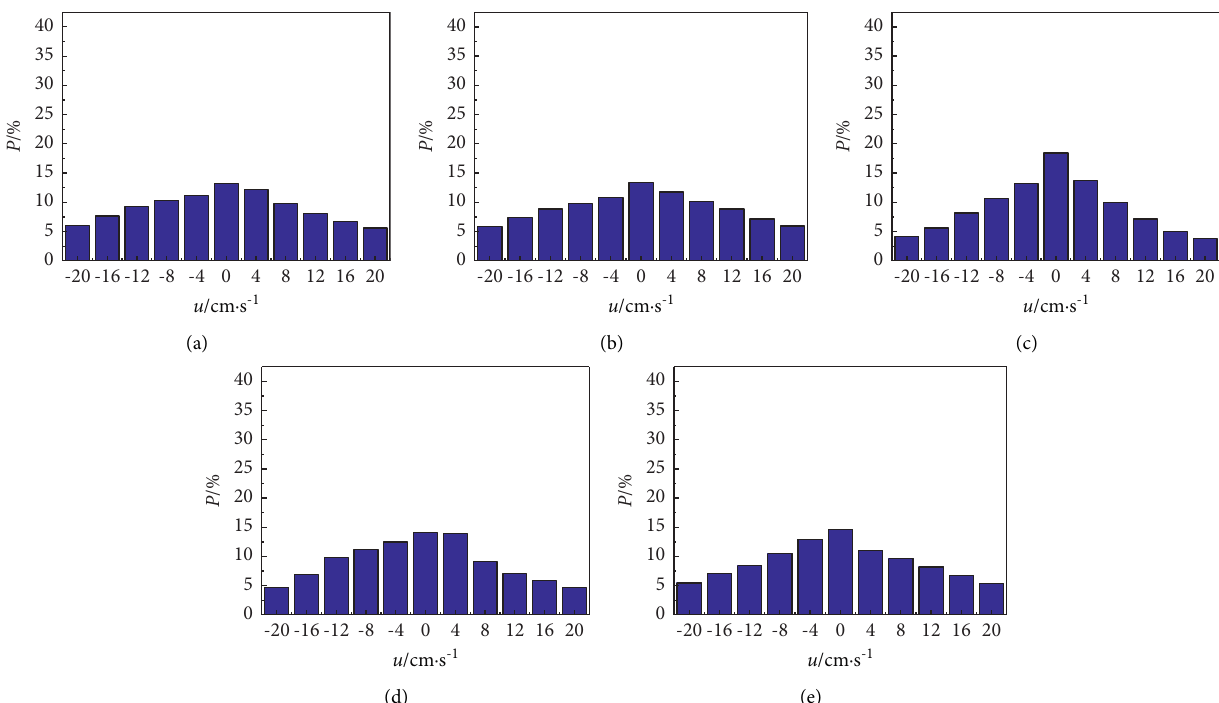
Figure 5: The probability distribution of longitudinal pulsation velocity in different working conditions. (a) H25-1, (b) H25-1.2, (c) H25-1.5 (D252), (d) D251, and (e)